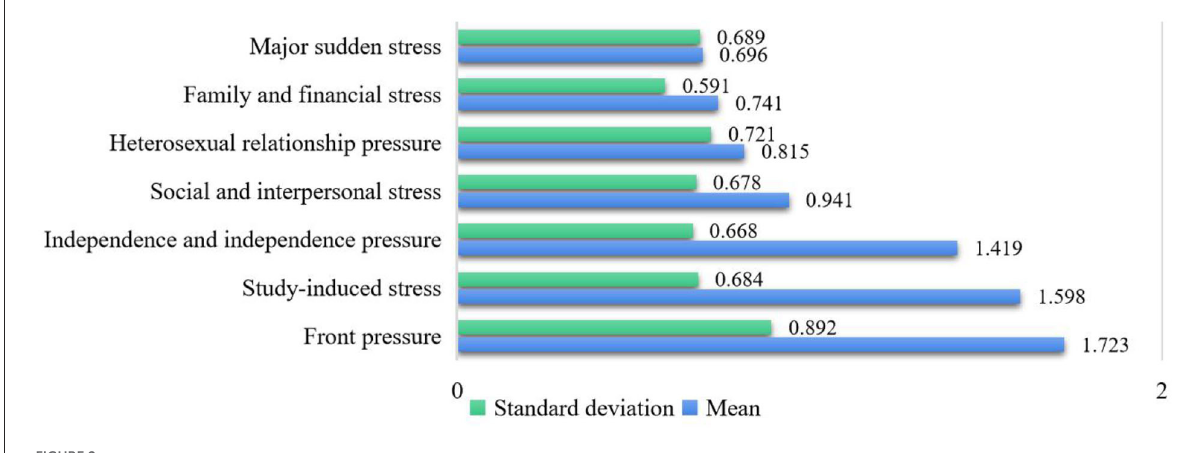
FIGURE2 Score statistics of each dimension of college students’ stressors.